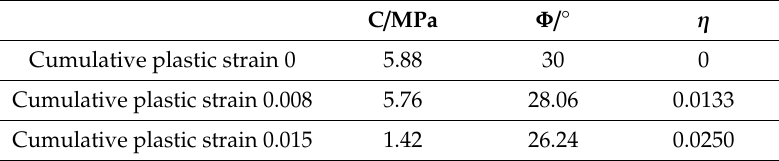
Table 2. Variation of coal sample strength parameters at di ff erent